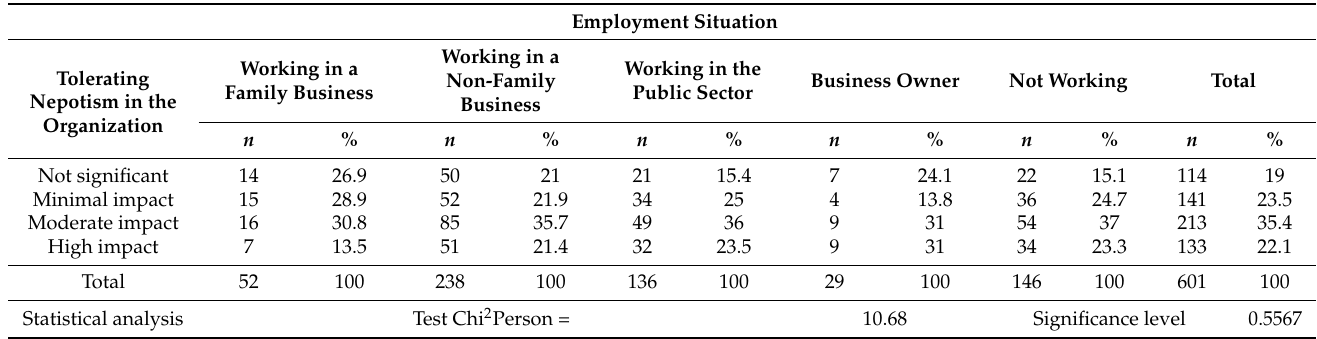
Table 4. Statistical analysis of the assessment of the impact of the Covid pandemic on the tolerance of nepotism depending on the workplace.